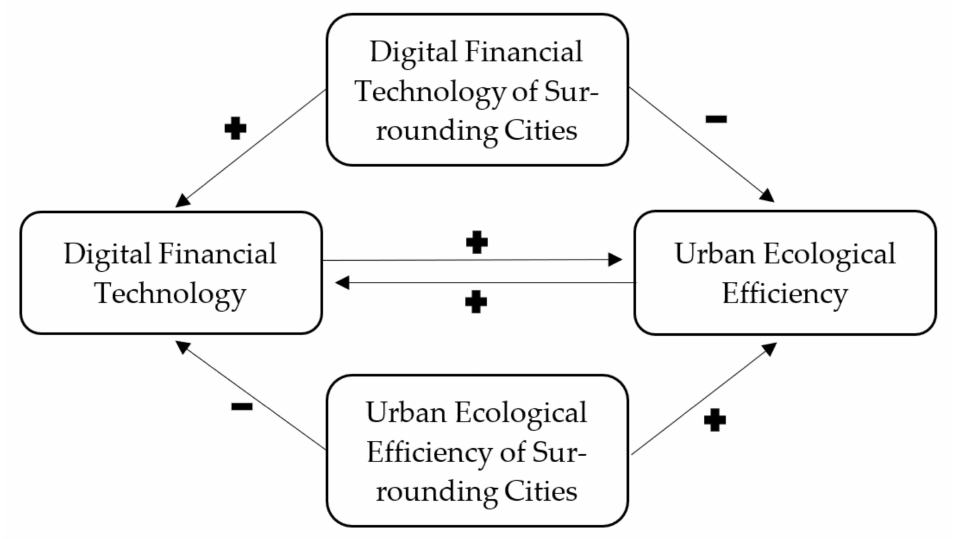
Figure 2. Interactive mechanism of digital financial technology and urban ecological